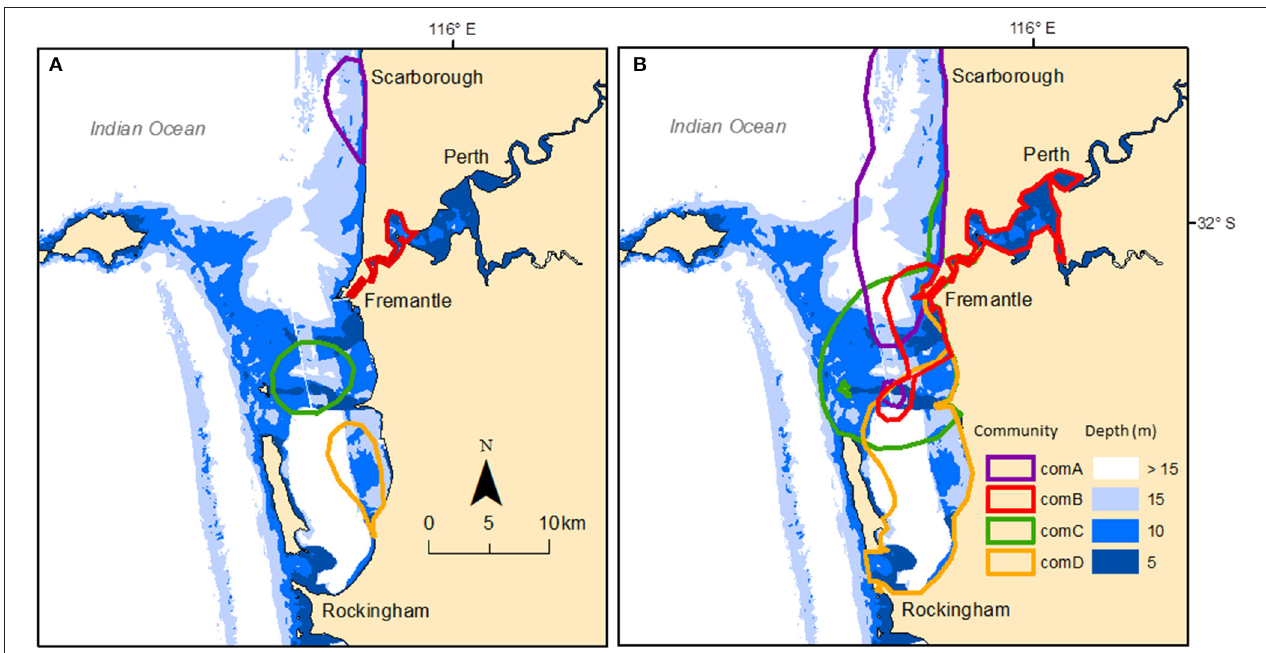
FIGURE 5 | Study area showing the bathymetry and core areas (A) based on the 50% kernel density and home ranges (B) based on the 95% kernel density estimated for each community using clustered individual sightings. Communities are: ComA-purple; ComB-red; ComC-green; and